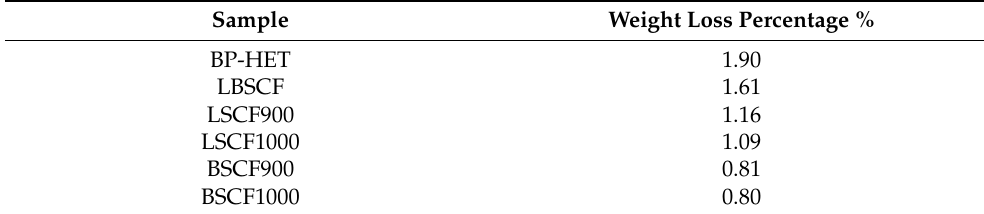
Figure 5. Panel ( a ): TGA curves calculated from Step 4 (see experimental part) for BP-HET (black line), and LBSCF (red line). Panel ( b ): H 2 -TPR profiles for BP-HET (black line), and LBSCF (red line). Table 3. Summary of TGA experiments per gram of